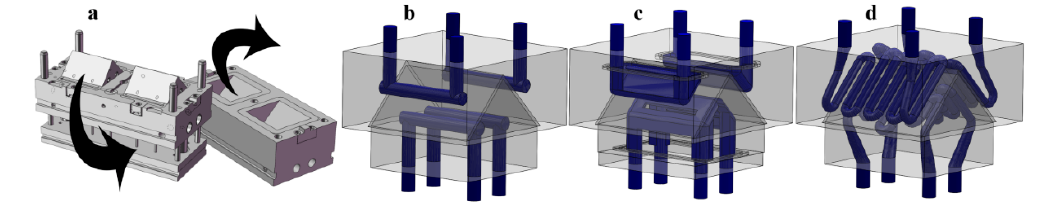
Figure 2. ( a ) The injection mold block used in the simulations, and the ( b ) Conventional, ( c ) Milled, and ( d ) Conformal cooling systems of the inserts.